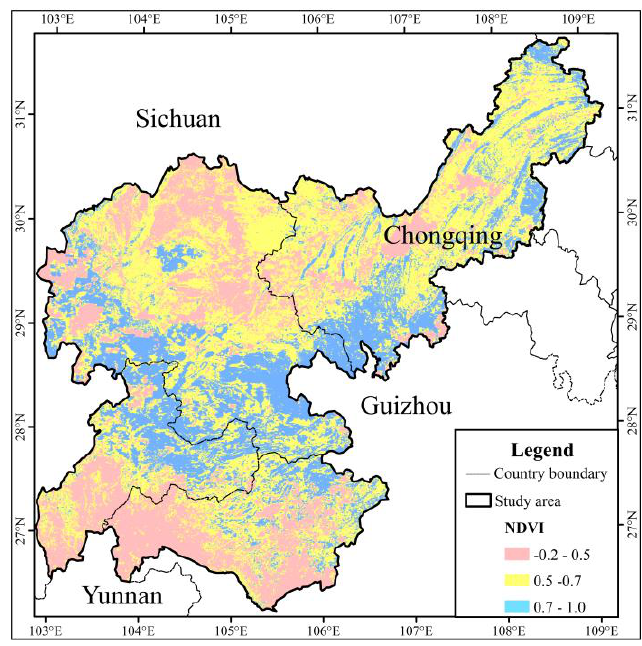
Figure 11. Map of normalized difference vegetation index.